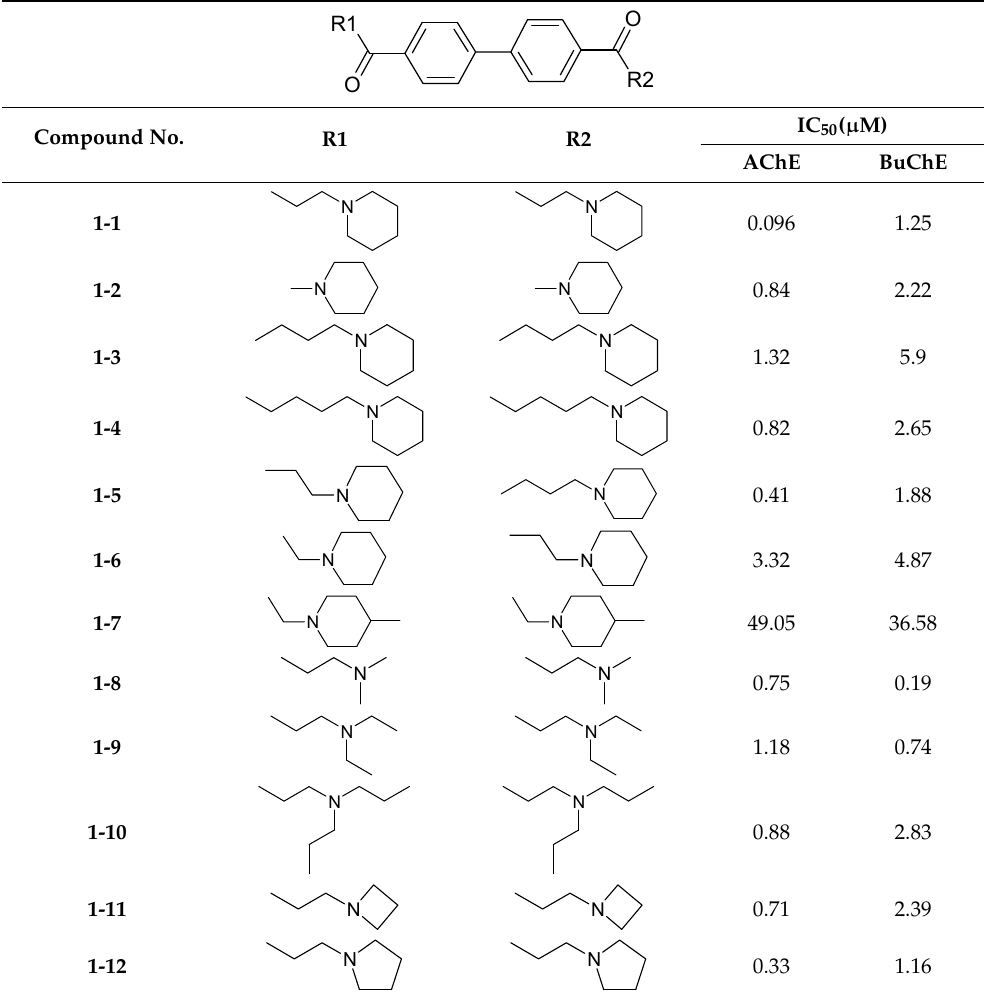
Table 1. The chemical structures and biological activities of DL0410 and its 50 derivatives as AChE and BuChE inhibitors.